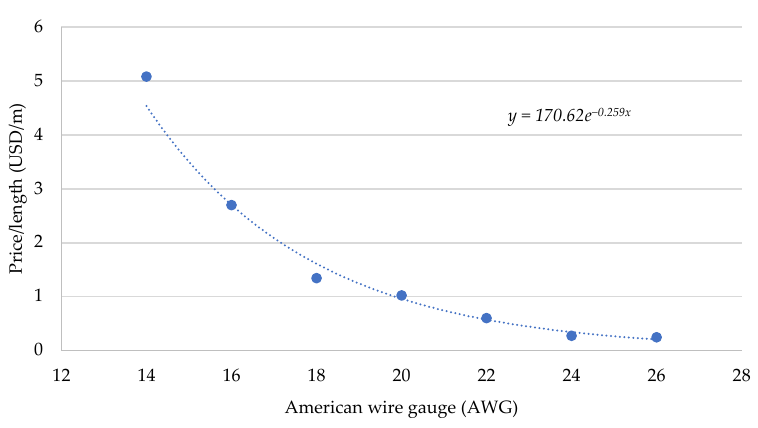
Figure 12. Price of Litz wire according to the AWG. 4.5. Cost Comparison between Single-Ended and Double-Ended Converters Figure 13 compares the cost of forward converters obtained using the cost model of parts. Converters account for a large portion of the price in the order of inductor, trans- former, power MOSFET, and diode. Since the inductor and capacitor used in the second- ary of the transformer are the same in both converters, the price is also the same. In the